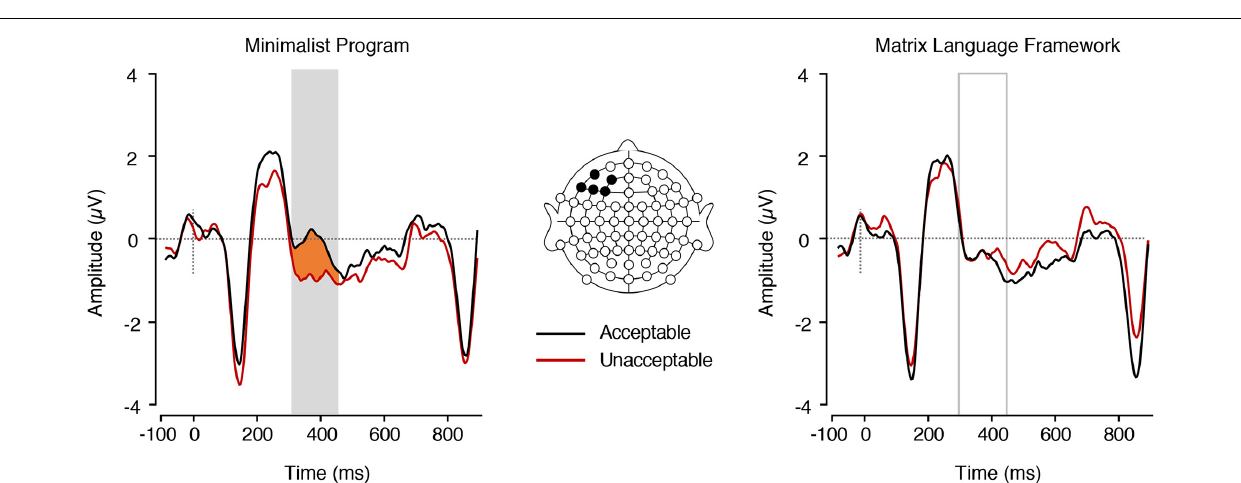
FIGURE 3 | ERPs elicited by nouns preceded by adjectives. Left , in the MP+ and MP– conditions (main effect of MP). The plain grey box indicates the time window of the LAN analysis in which mean ERP amplitudes significantly differed between conditions (300–450 ms post-stimulus). Right , in the MLF+ and MLF- conditions (main effect of